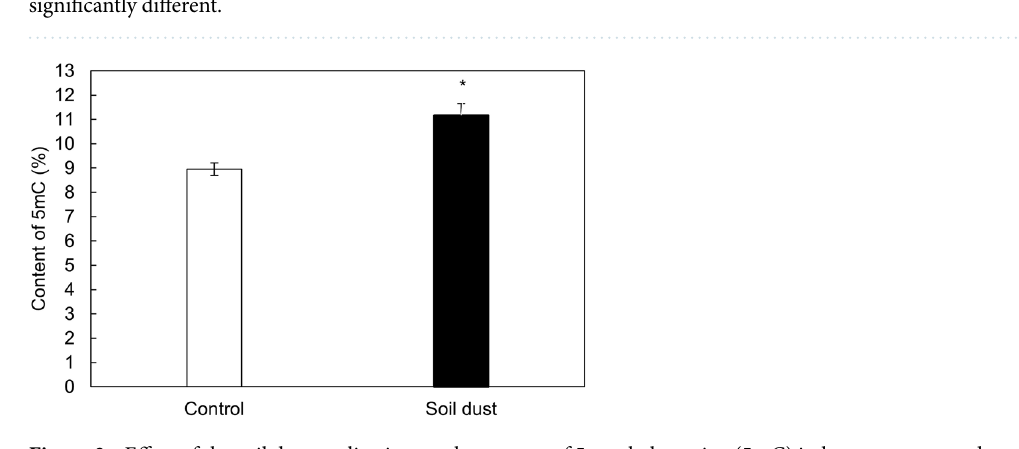
Figure 3. Effect of the soil dust application on the content of 5-methylcytosine (5mC) in lettuce grown under hydroponic conditions. Significant differences between treatments are indicated by asterisks (ANOVA; Fisher’s LSD test; p ≤ 0.05).